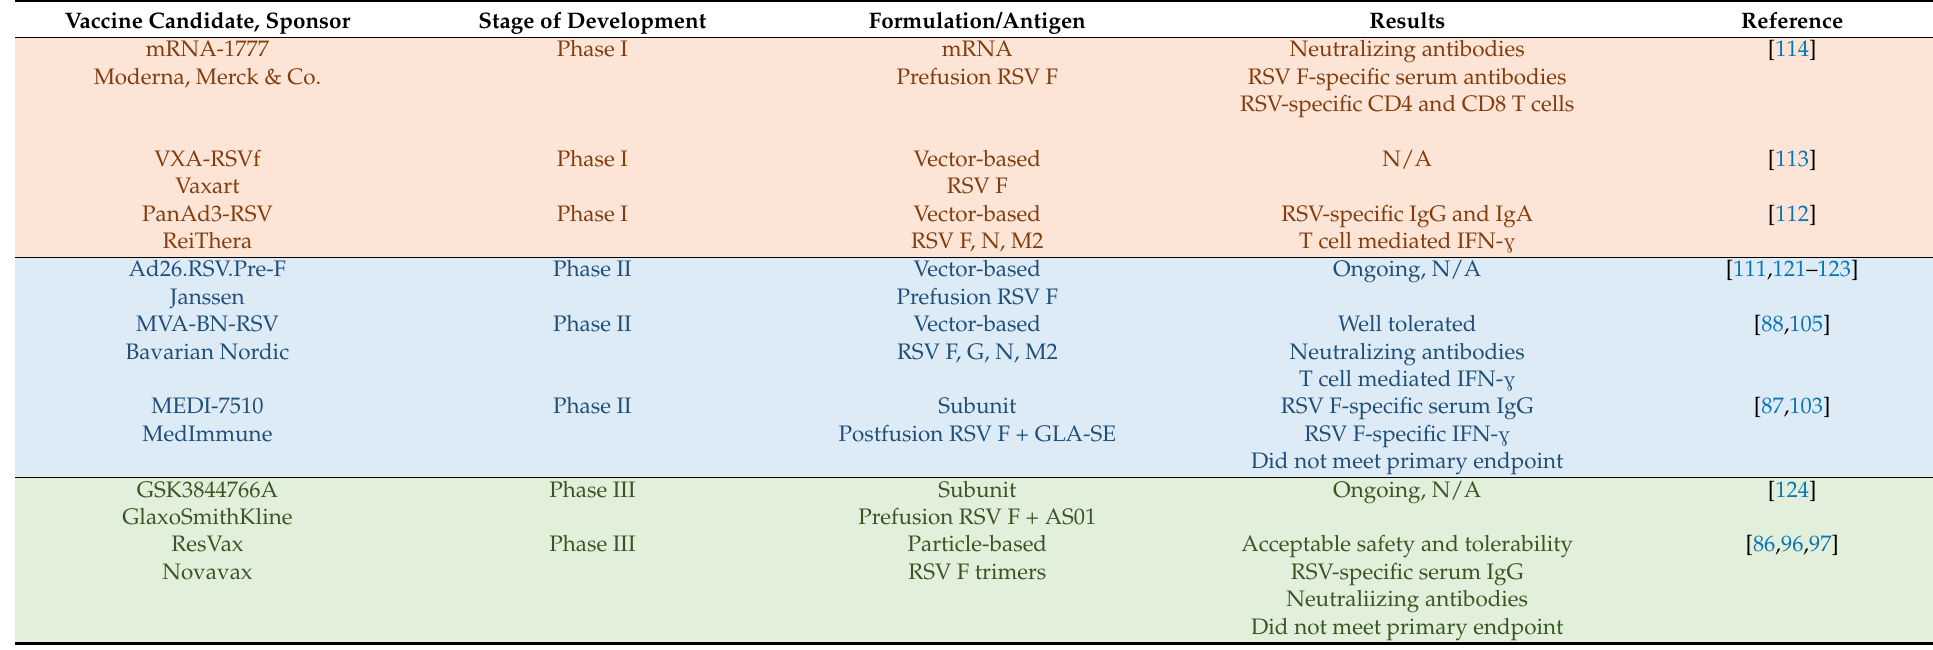
Table 1. RSV vaccine candidates targeting elderly adults in clinical